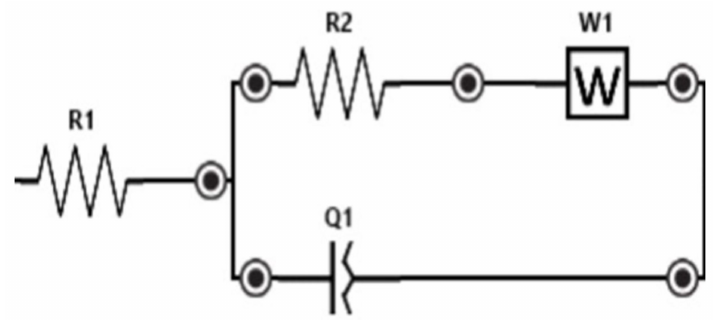
Figure 4. Randles’ equivalent circuit describing the Nyquist plot of Figure